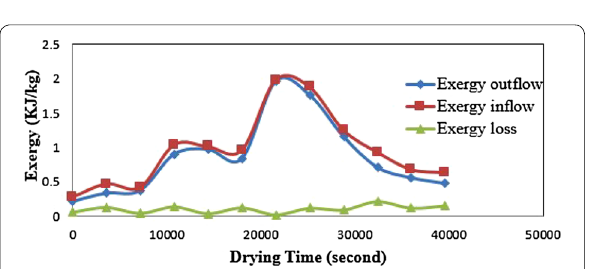
Fig. 6 Exergy as a function of time (3rd day) tomato